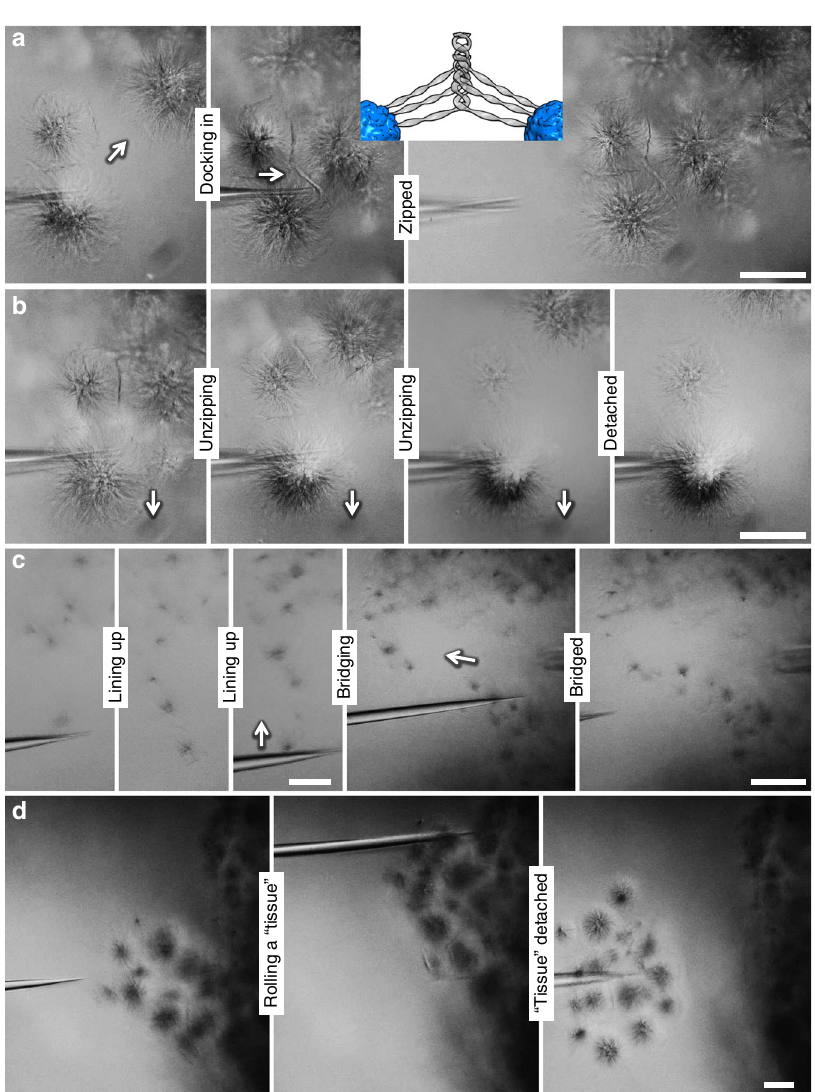
Fig. 6 Micromanipulation of aster clusters. a When two asters are docked into a third one, the ribbons zip up in the boundaries (inset scheme) to form strong junctions. b The two asters are dragged away from the third one, causing unzipping and eventual detachment. c Asters are maneuvered to form a line and a bridge. d An aster cluster is rolled on a surface and then removed from the surface. Scale bars = 50 μ m ( a – d